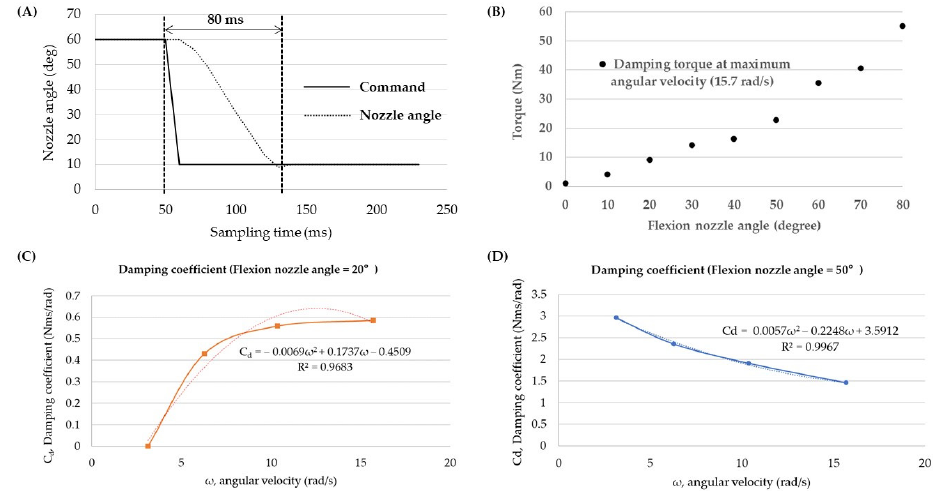
Figure 10. Nozzle characteristics test: ( A ) nozzle response test according to shifting nozzle angle; ( B ) cylinder damping torque at maximum angular velocity (15.7 rad/s) according to nozzle angle using the Instron test machine and a digital torque wrench; the damping coefficient according to angular velocity at the nozzle angle of ( C ) 20 degrees and ( D ) 50